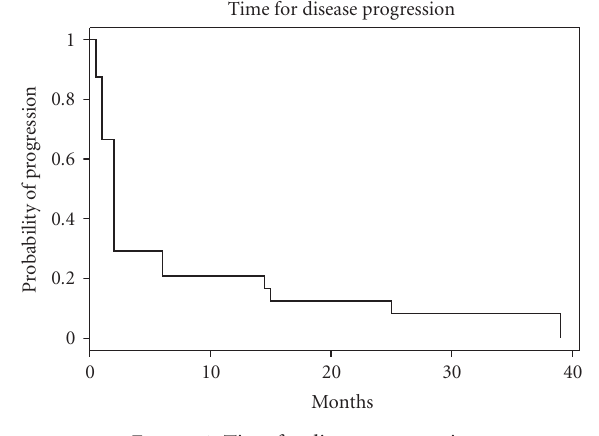
Figure 1: Time for disease progression.